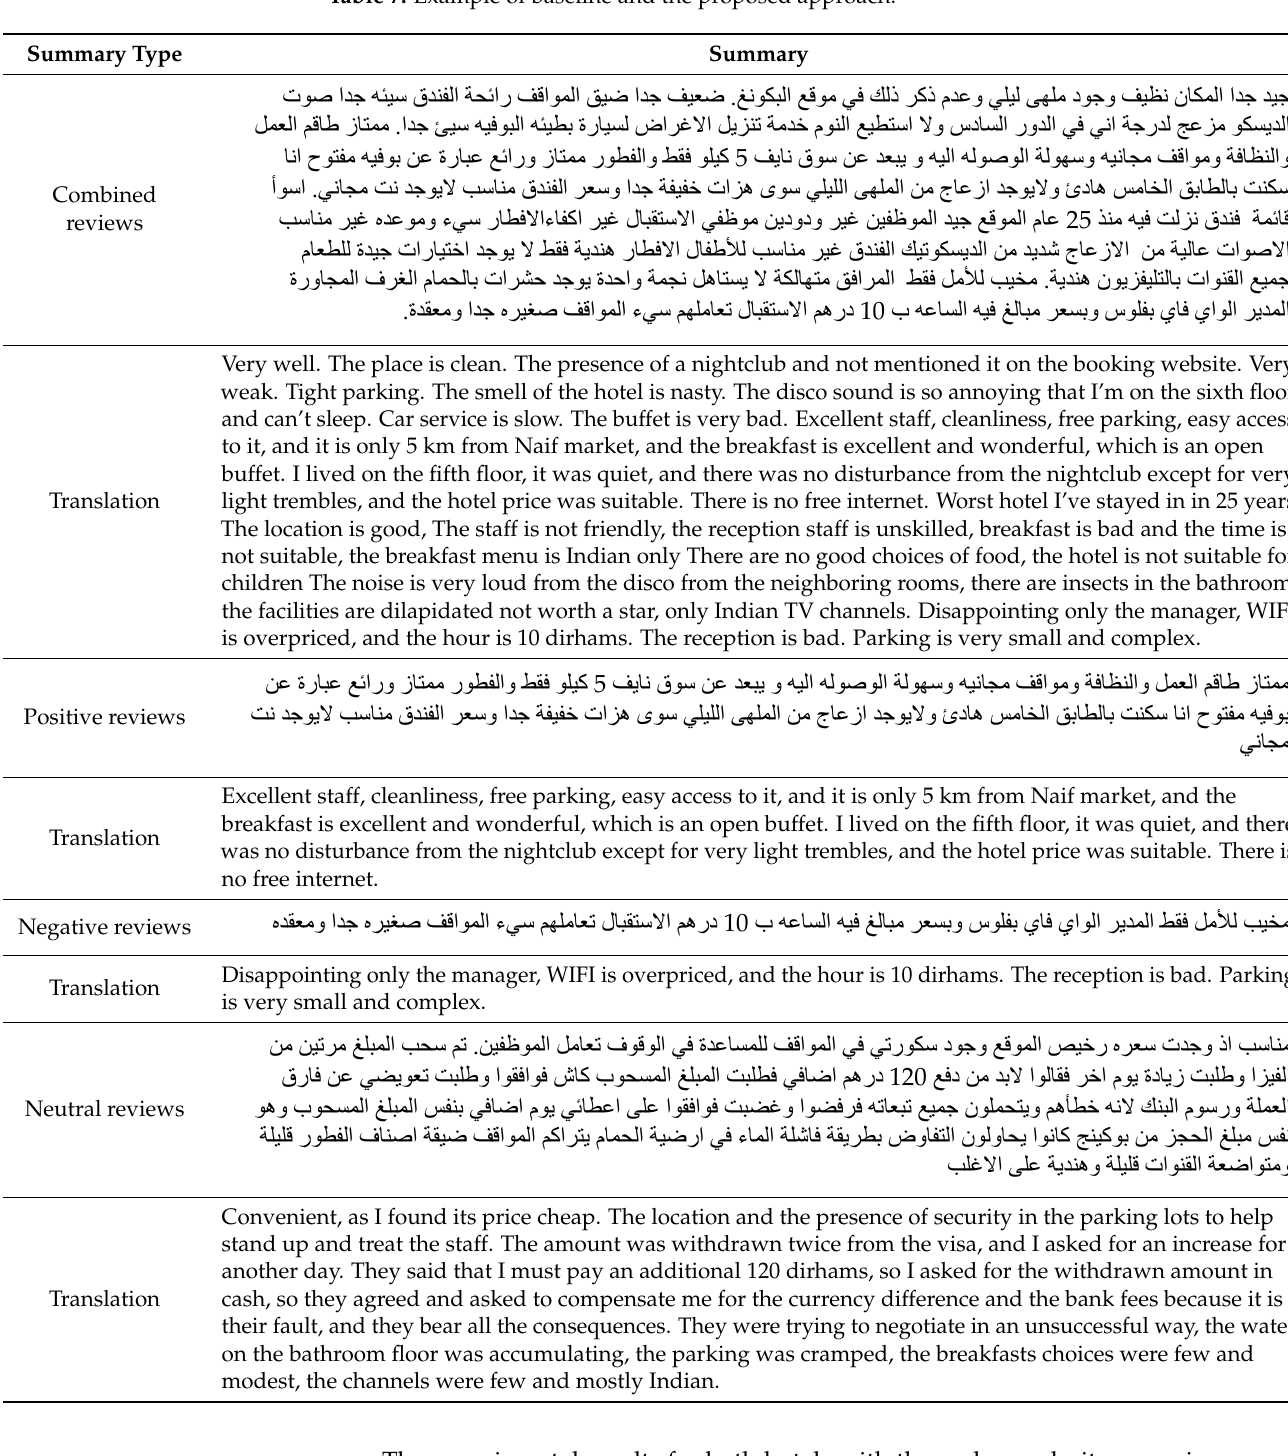
Table 7. Example of baseline and the proposed approach.